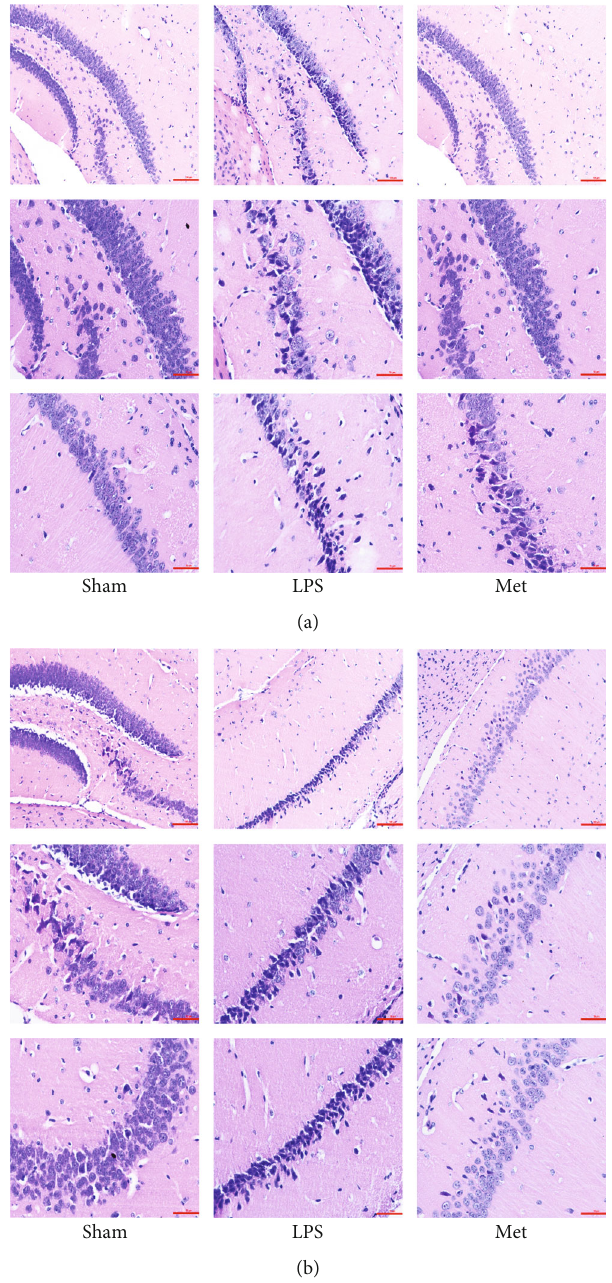
Figure 4: (a) HE staining of adult group, (b) HE staining of aged group. HE staining showed that in fl ammation and cell arrangement disorders were observed in both adult and aged mice after LPS injection, especially in dentate gyrus. In the metformin-treated group, the aged mice had more in fl ammatory cells than the adult